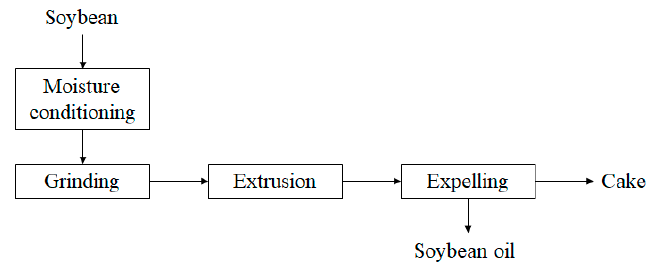
Figure 1. Schematic flow chart of typical extruding-expelling process.